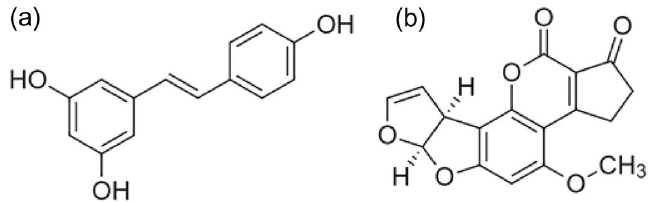
Figure 1. Chemical structure of (a) trans -resveratrol and (b) aflatoxin B 1